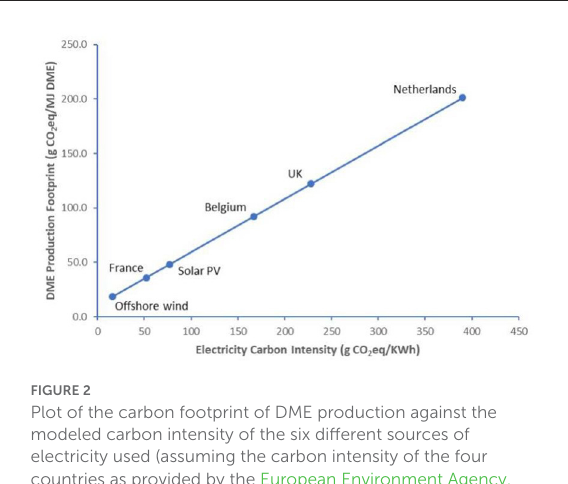
FIGURE2 Plot of the carbon footprint of DME production against the modeled carbon intensity of the six different sources of electricity used (assuming the carbon intensity of the four countries as provided by the European Environment Agency, 2020).